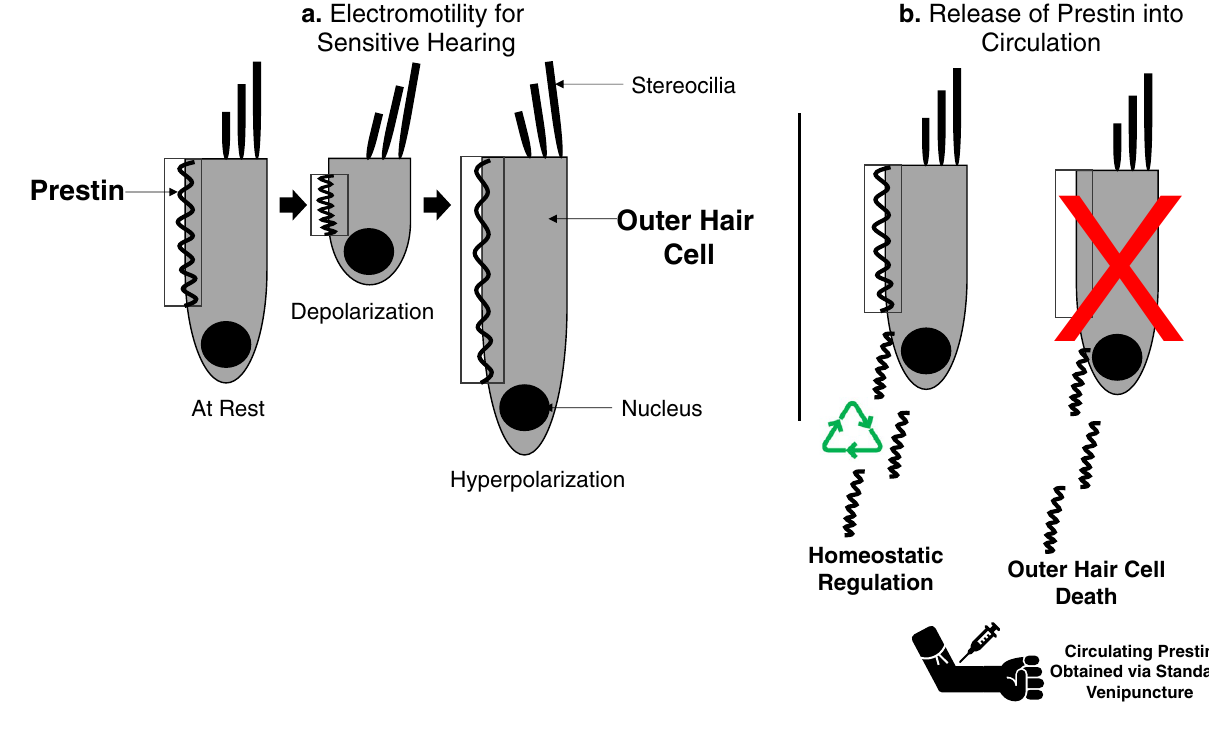
Figure 1. Highly simplified schematic depiction of outer hair cell (OHC) somatic electromotility and mechanisms for circulating prestin. ( a ) Prestin generates somatic electromotility, the contraction and elongation of OHCs in response to changes in transmembrane potential. This electromotility underlies acute auditory sensitivity. ( b ) Two postulated triggers for prestin entering the bloodstream: prestin is continuously recycled as part of the homeostatic regulation of cochlear function (left), and prestin enters circulation after outer hair cell death